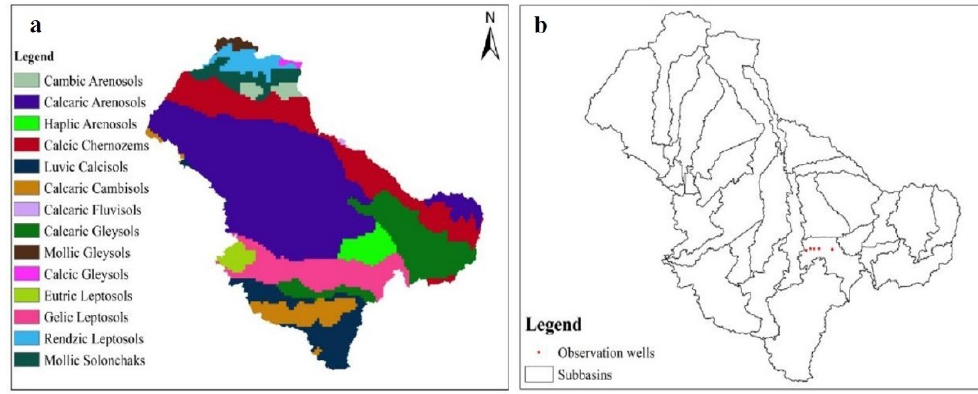
Figure 5. ( a ) Soil types in the study area and ( b ) sub ‐ basins input to the SWAT model. Land use type data for the simulated period (2000–2018) were derived from 30 m Landsat images. Remote sensing interpretation marks were created according to spectral